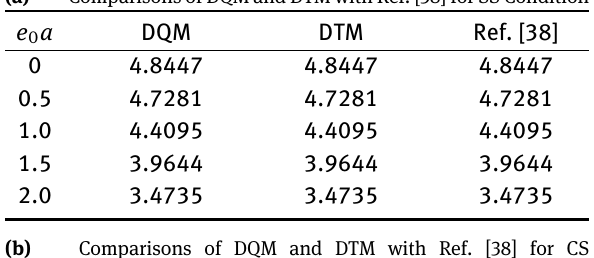
(b) Comparisons of DQM and DTM with Ref. [38] for CS